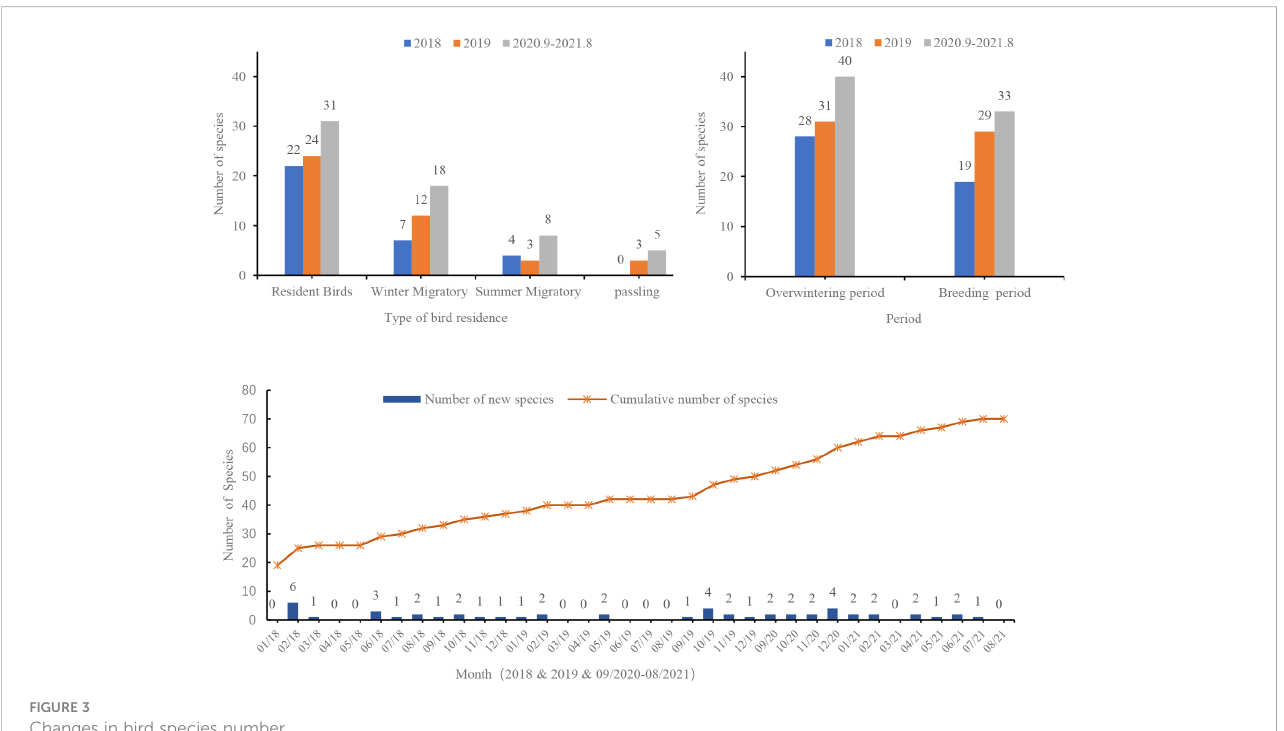
FIGURE 3 Changes in bird species